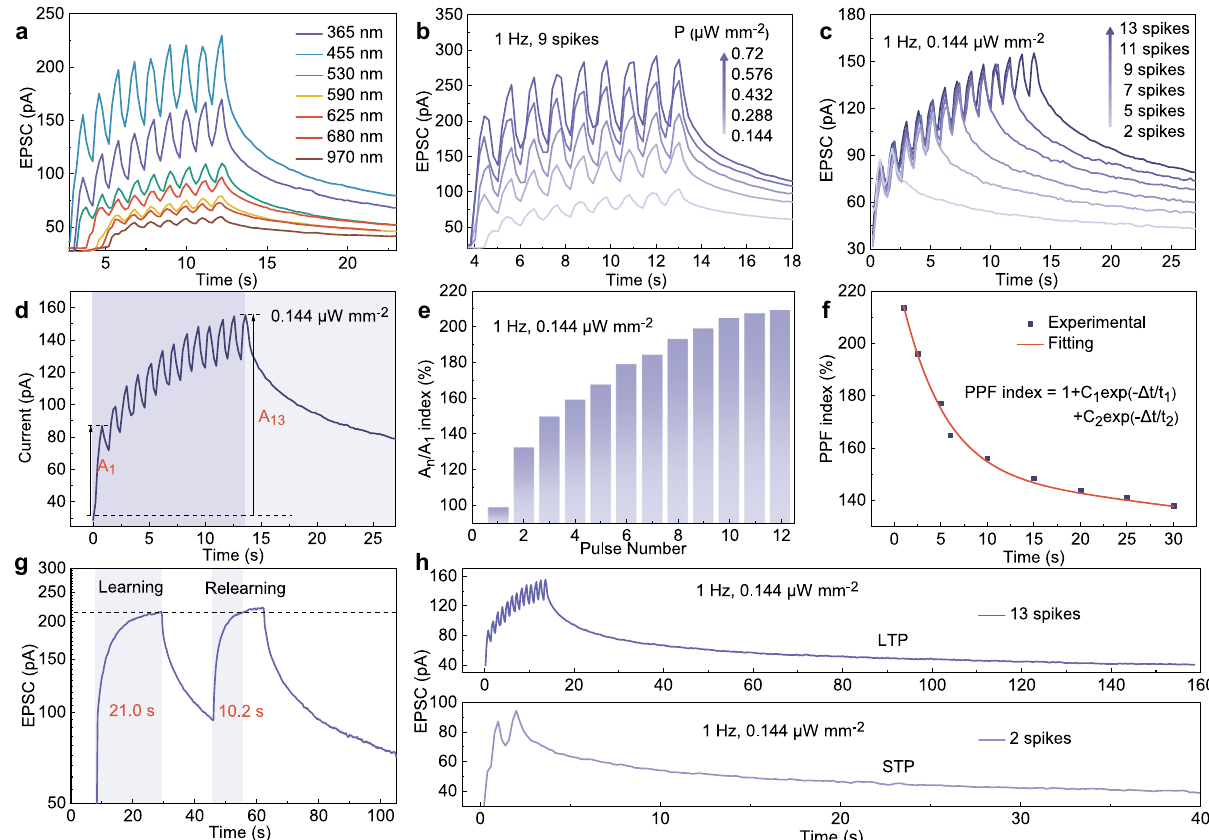
Fig. 4 | Phototunable synaptic properties. EPSCs in response to nine successive light pulses a under UV, visible and infrared light sources and b under different powerswitha fi xedwavelengthat365nmandafrequencyof1Hz. c In fl uenceofthe